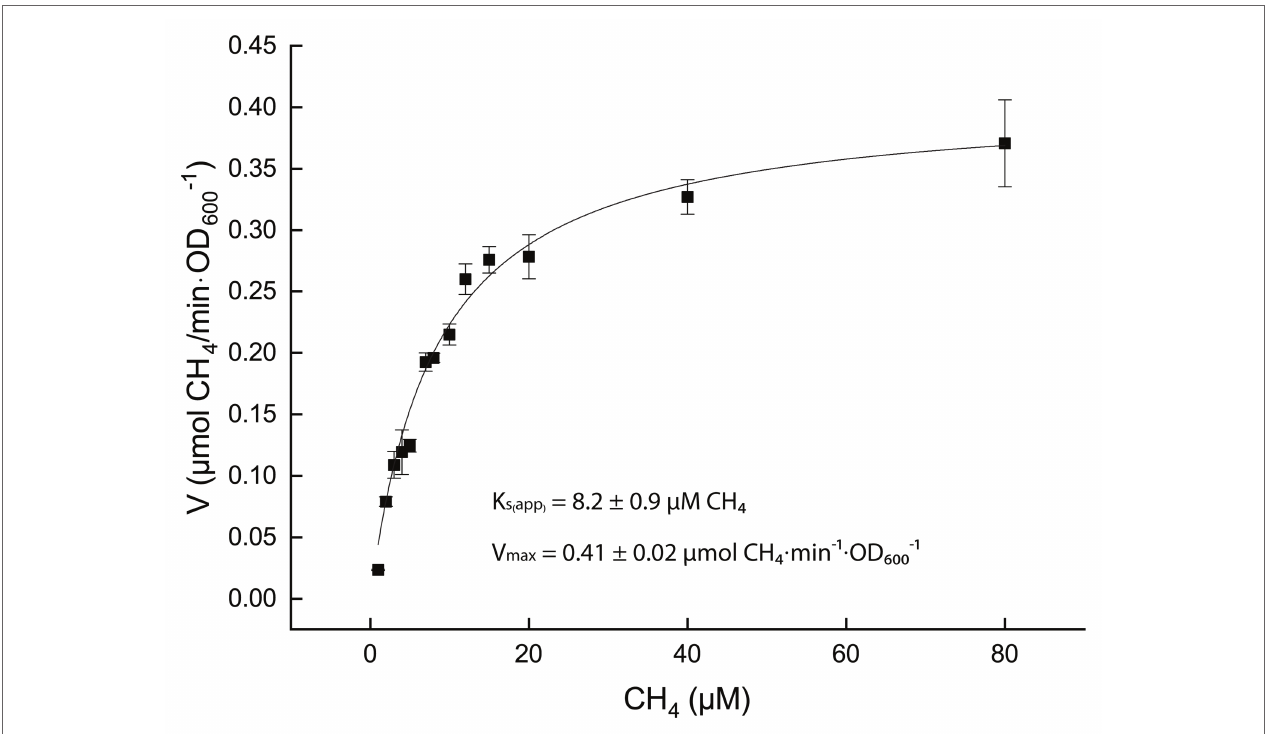
FIGURE 4 | Kinetics of methane oxidation. Black squares represent the average over three biological replicates and the SD in expressed as error bars. The black curve is the result of the best fitting curve for a Michaelis-Menten kinetics (R 2 =